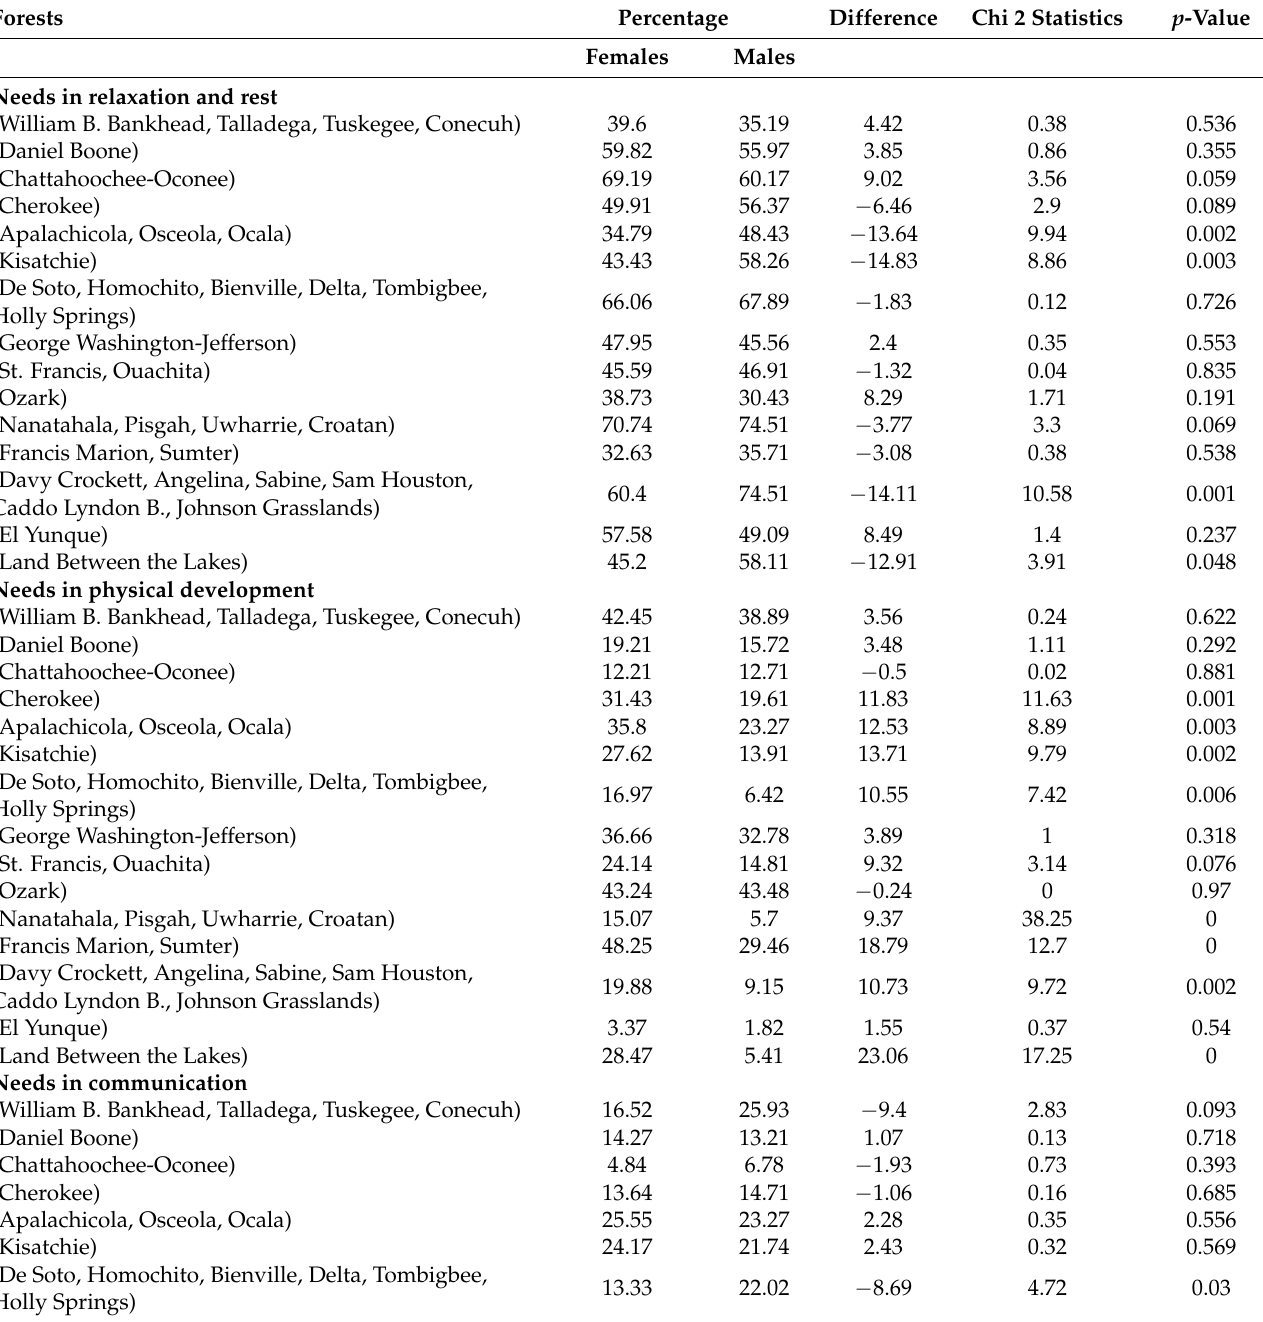
Table 5. The results of the Chi-squared test for between-group (age) comparisons across forests. Forests Percentage